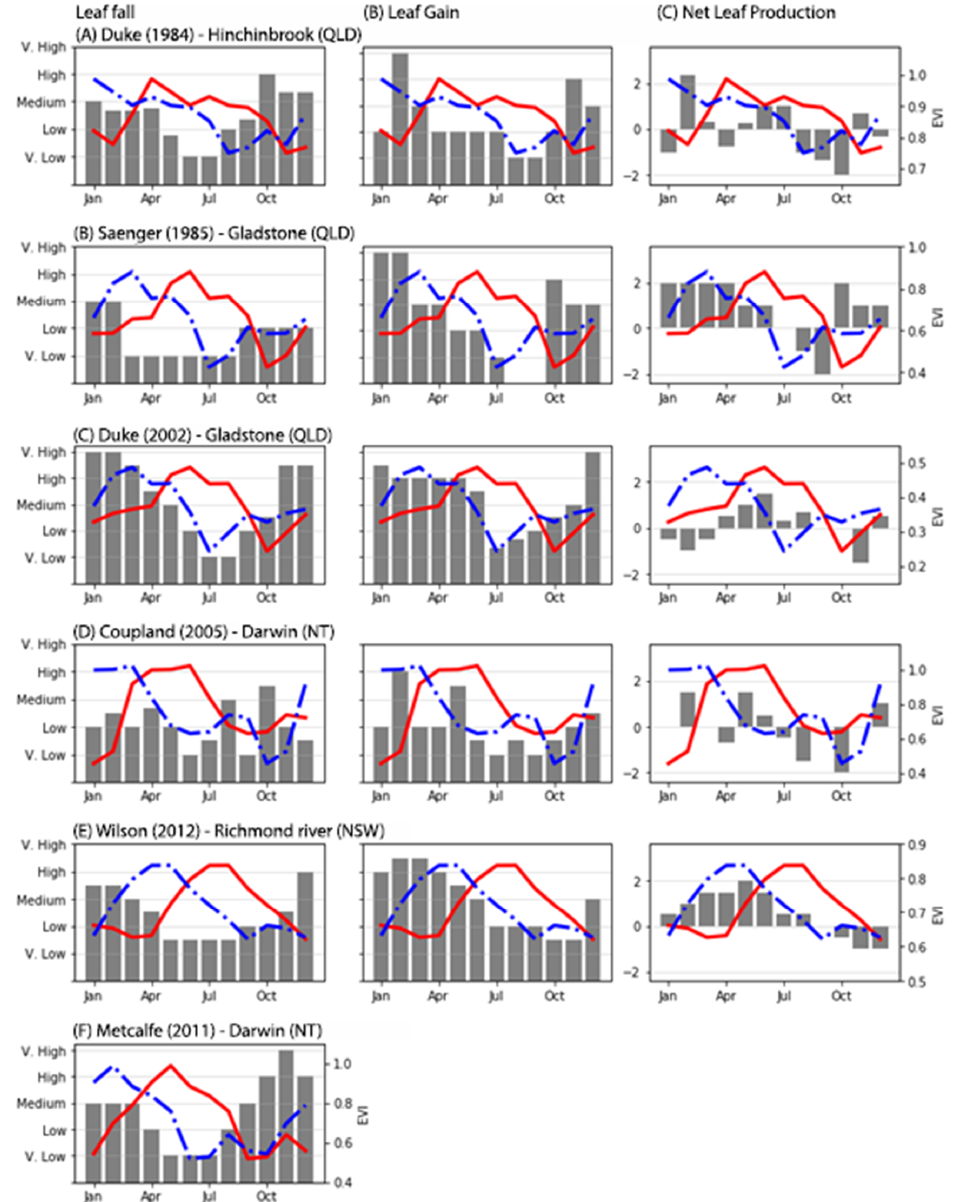
Figure 6. Panels ( A ) through ( F ) display the a qualitative measure of Leaf fall, Leaf gain and Net Leaf Production for each study site on the left, right and center respectively. Each panel represents a different study site. The red line represents the monthly value of the apparent phenology from the GAMs and the blue dotted line represents the apparent phenology shifted by three months.